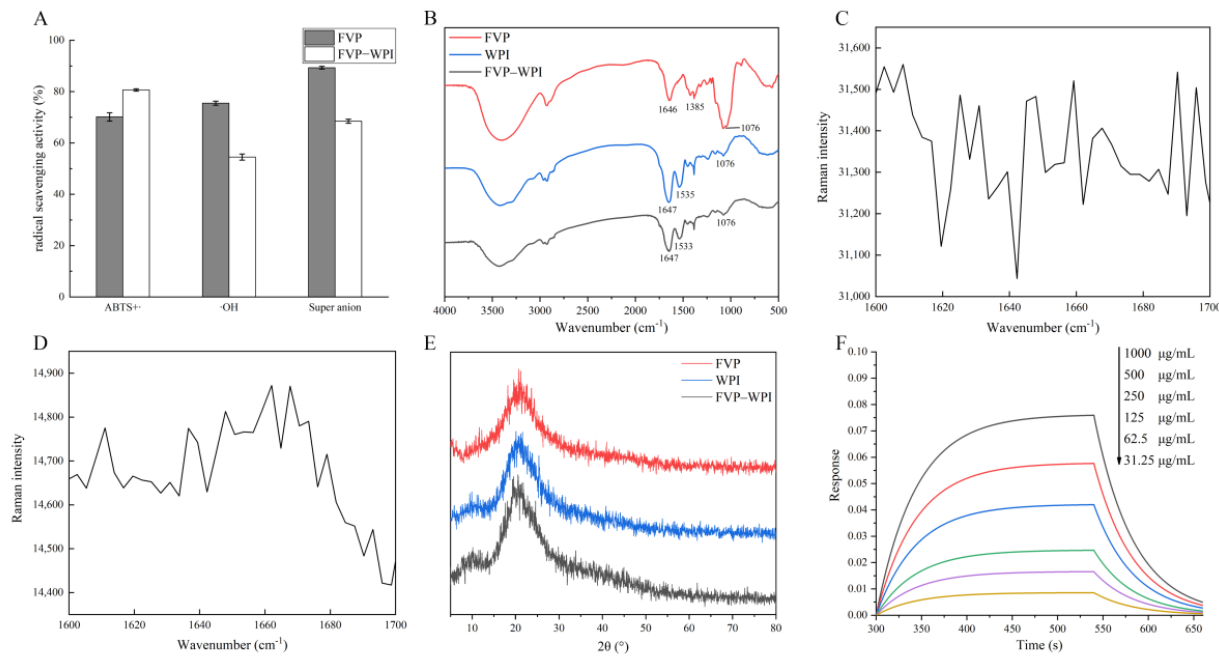
Figure 5. Antioxidant activities and structures of FVPs, WPI, and FVP–WPI. ( A ) The antioxidant activities of FVPs and FVP–WPI, ( B ) the FTIR spectra of the FVPs, WPI, and FVP–WPI complex, ( C , D ) the amide I bands of WPI and FVP–WPI in Raman spectra, ( E ) the XRD spectra of the WPI, FVPs, and FVP–WPI, ( F ) the fitting curves for association and dissociation of FVPs and WPI.